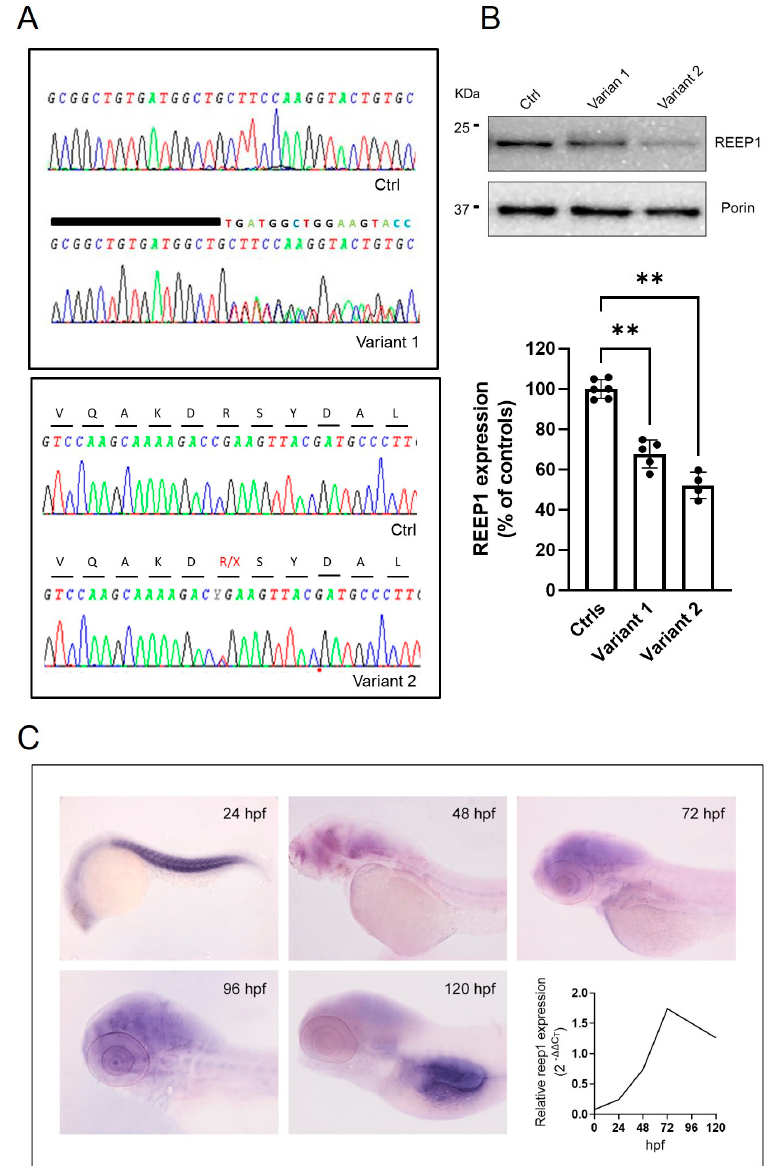
Figure 1. Molecular studies in the analyzed disease models. ( A ) Genetic studies of DNA from mutated fibroblasts show the electropherogram of exon 5 flanking the c.401_409dup9del19 and c.337C > T mutations. A wild-type REEP1 sequence is also reported as a reference. ( B ) Representative WB and quantification of REEP1 protein expression levels related to both mutant cell lines and control. Porin expression was used as a loading control. A significant reduction in REEP1 protein expression was observed with residual levels between 50 and 70% compared to controls. Three different control fibroblasts (in technical duplicate) and two subjects for each mutation (in technical triplicate) were analyzed and plotted both as individual values and histograms with mean and SD. ANOVA test (one-way ANOVA) was used to compare the mean levels of each mutated line with the control mean. ** p < 0.01. ( C ) Spatial-temporal expression of reep1 mRNA during zebrafish embryogenesis. WISH of zebrafish reep1 was performed at different developmental stages (from 24 to 120 hpf), and qRT − PCR analysis showed reep1 developmental relative expression from 0 hpf to 120 hpf in WT